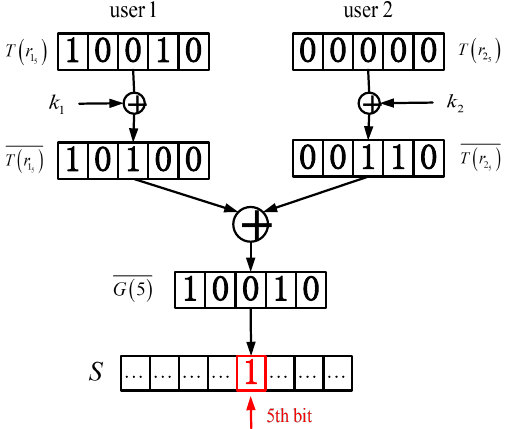
Figure 3. An example of determining the 5th bit in FM sketch S with the bitwise XOR homomorphic encryption, where the coding scheme defined the length of the bit string T ( r i the aggregation result is not influenced by the operations of user’s privacy